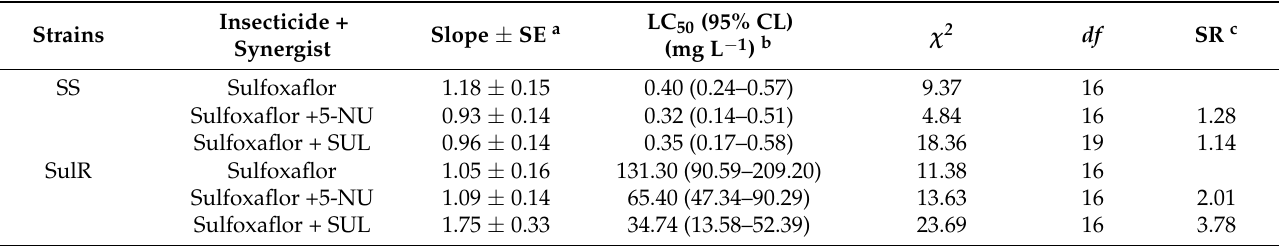
Table 2. Synergistic effects of 5-NU and SUL on the toxicity of sulfoxaflor in the susceptible and sulfoxaflor resistant strains of Aphis gossypii .